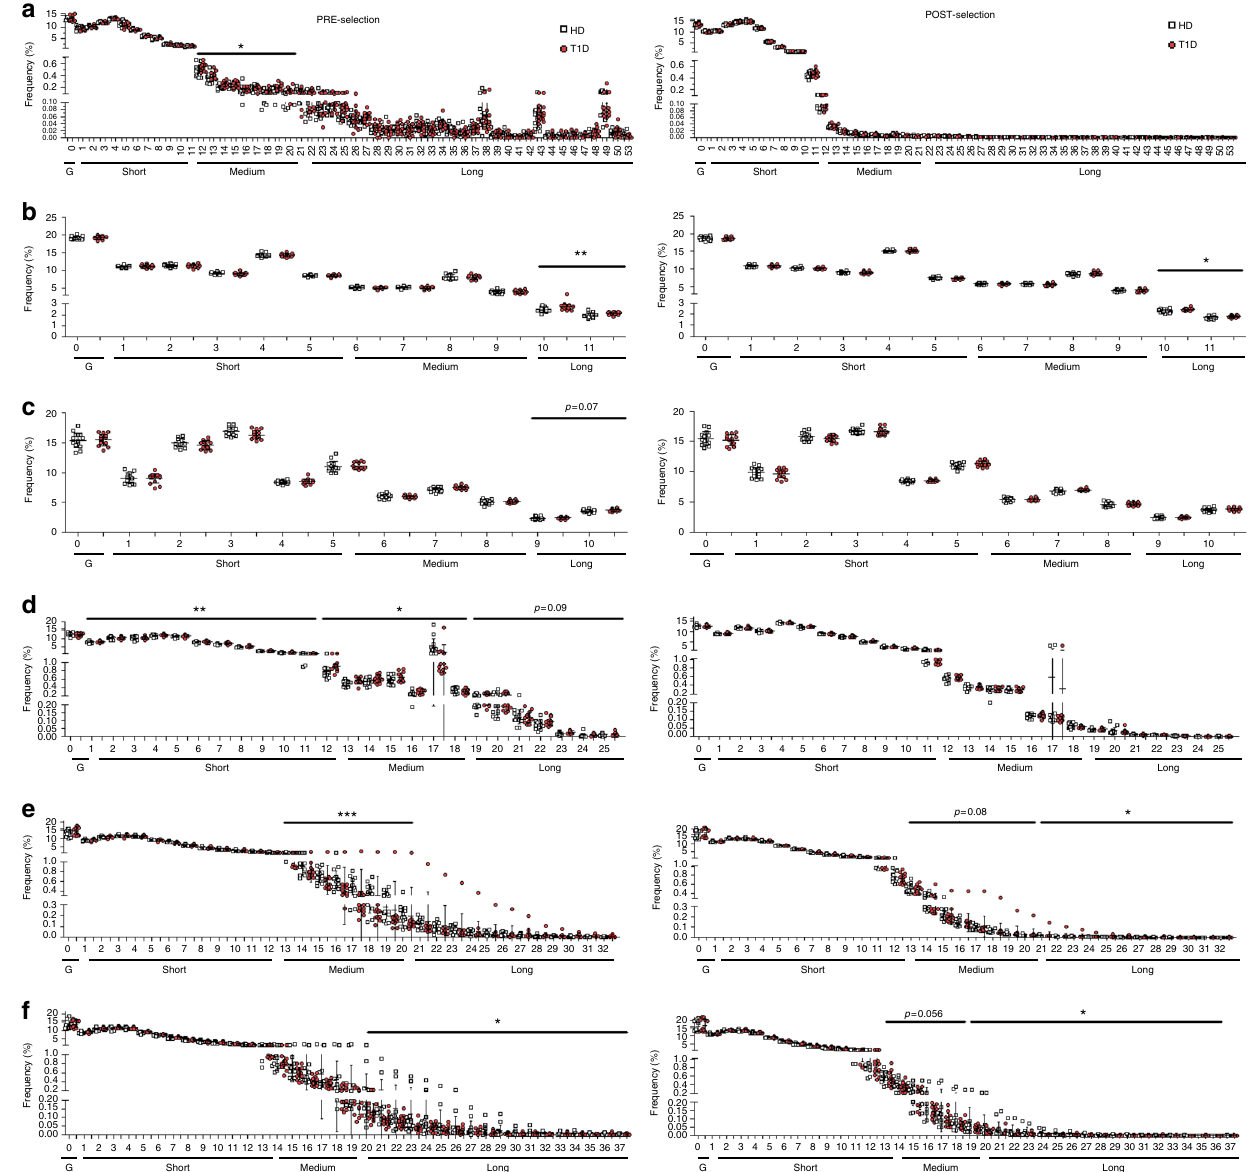
Fig. 5 Type 1 diabetes patients present altered indel patterns during TCRB rearrangement. OOF unique sequences from true naive (TN) cells (pre-selection clonotypes) were analyzed for the number of deletions and insertions at each of the 6 rearrangement sites (left column). The same analysis was performed for productive unique sequences from the same TN cells (post-selection clonotypes) (right column). The deletions (and insertions) were classi fi ed as short, medium or long depending on their frequency in the overall distribution for each of the 6 rearrangement sites. a Vdel. b D5del. c D3del. d Jdel. e n1ins. f n2ins. G: germline (no deletions/insertions). Short: 1 – 11 (Vdel, Jdel), 1 – 5 (D5del, D3del), 1 – 12 (n1ins), 1 – 13 (n2ins). Medium: 12 – 21 (Vdel), 6 – 9 (D5del), 6 – 8 (D3del), 12 – 18 (Jdel), 13 – 20 (n1ins), 14 – 19 (n2ins). Long: 22 – 65 (Vdel), 10 – 11 (D5del), 9 – 10 (D3del), 19 – 25 (Jdel), 21 – 32 (n1ins), 20 – 37 (n2ins). Type 1 diabetes (T1D) patients display higher frequencies of long deletions and lower frequencies of long insertions. In e the outlier (T1D #2) was removed for the statistical analysis. In d the class 17 nucleotides was not included in the Medium range of Jdel, as this class behaves as an outlier when compared to the other Jdel classes. a – f Unpaired t-test or Mann – Whitney U-test. * p < 0.05. ** p < 0.01. *** p < 0.001. Lines represent the mean ± SD and for cytomegalovirus (CMV) after stimulation in vitro 26 – 28 and obtain TCRB sequences from single cells 29 . We identi fi ed 219 GAD65-speci fi c TCRB sequences from 7 T1D patients, 155 GAD65-speci fi c TCRB sequences from 6 healthy donors and 122 CMV-speci fi c TCRB sequences from 1 control and 2 patients.